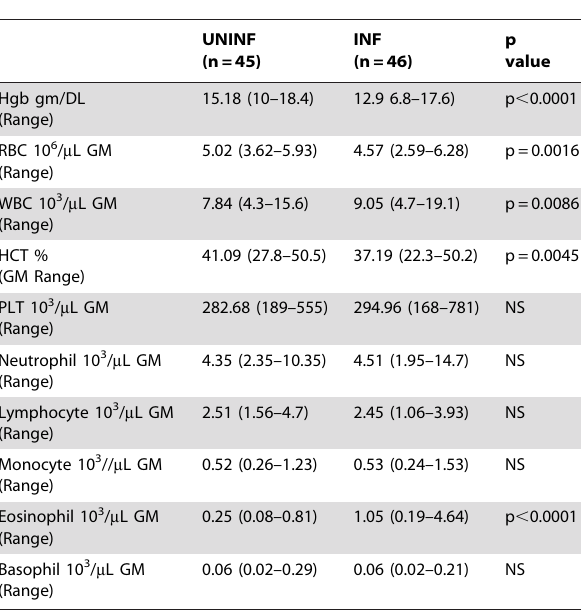
Table 1. Demographics and hematology